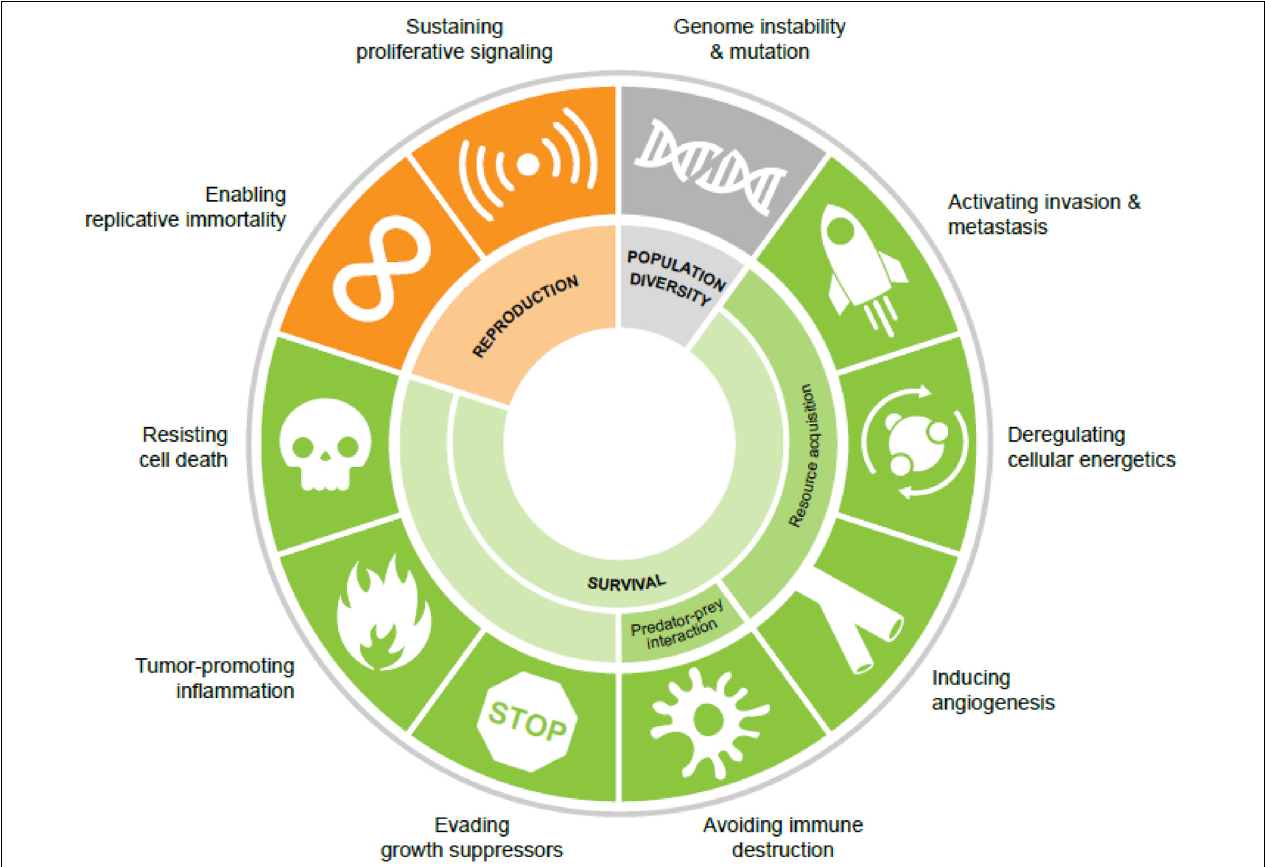
FIGURE 1 | The cancer hallmarks as ecological fitness parameters. Population diversity is driven by genome instability and mutation. Cancer cell fitness is governed by a series of survival phenotypes and the ability to reproduce (proliferation and replicative